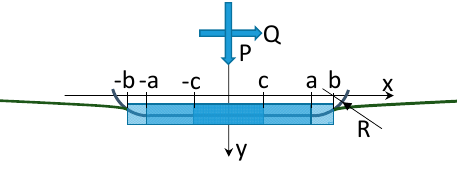
Figure 4. Rounded punch geometry.